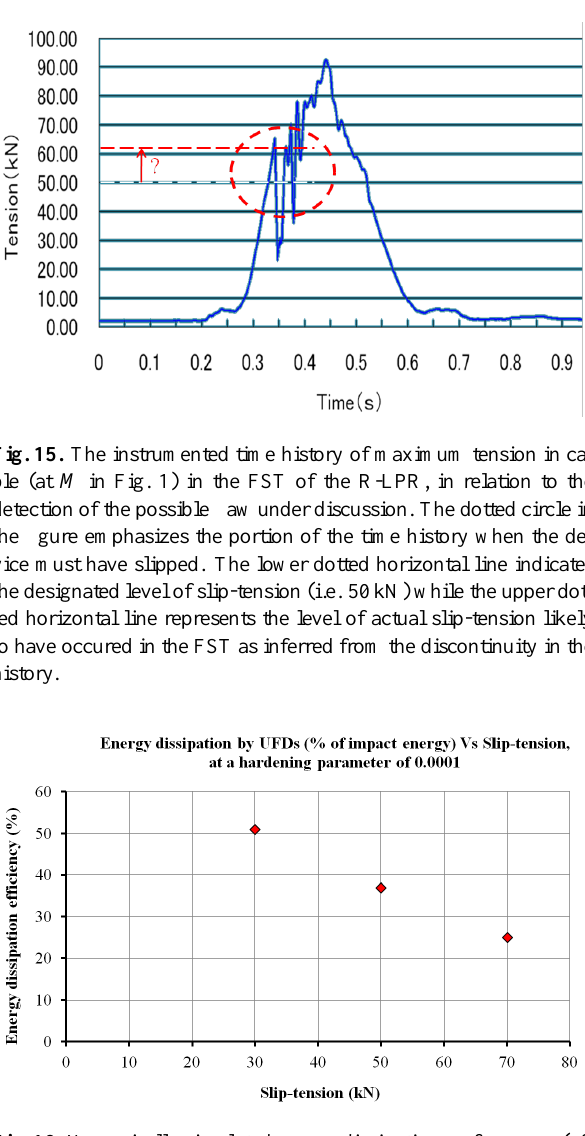
Fig. 16. Numerically simulated energy dissipation performance (ef- Figure 16. Numerically simulated energy dissipation performance (efficiency) of the UFDs 2 ficiency) of the UFDs integrated into the R-LPR structure as af- integrated into the R-LPR structure as affected by the slip-tension values at a given hardening 3 fected by the slip-tension values at a given hardening parameter. 4